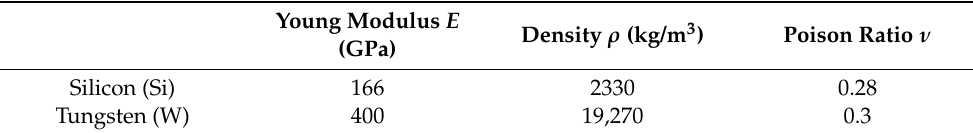
Table 1. Material parameters.